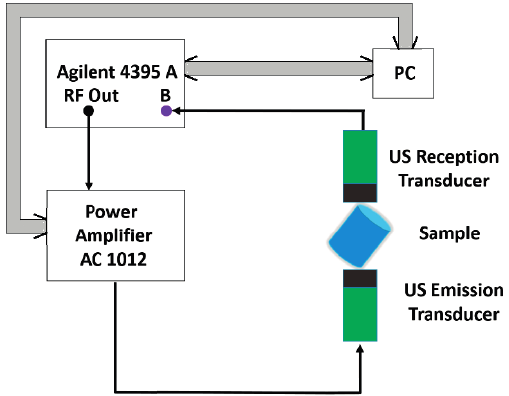
Figure 1. RUS Experimental setup schematic block diagram. Thin lines correspond to coaxial cable for sinusoidal wave transmission; thick lines are GPIB cable for digitalized